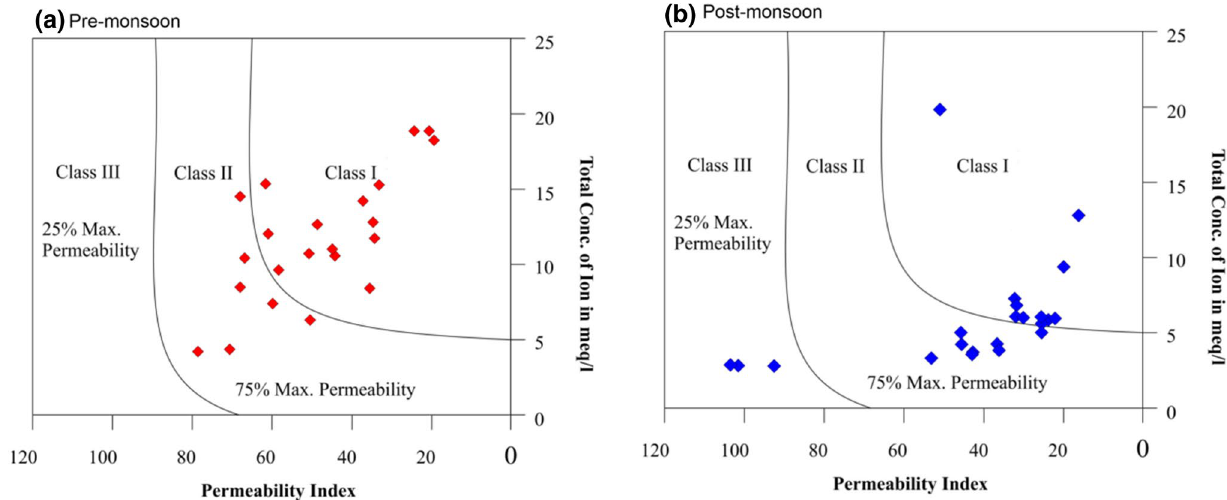
Fig. 11 Doneen’s chart for P.I. values; a PrM; b PoM